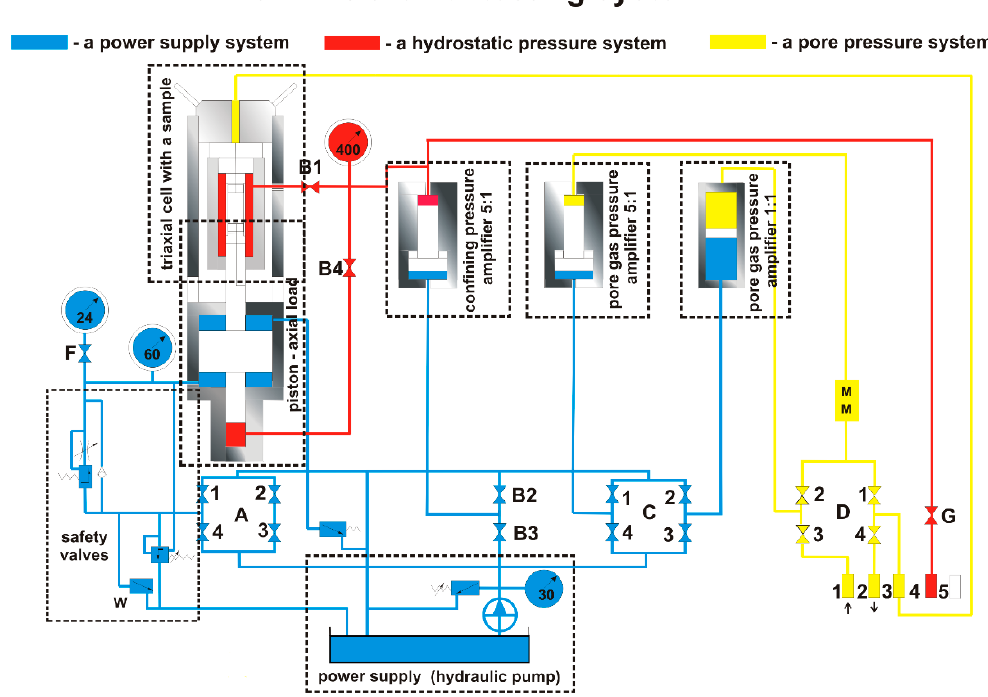
Figure 4. Diagram of the GTA-10 device: A1, A2, A3, A4—valves controlling the movement of the press piston, B1, B4—valves that control the flow of liquid in the high pressure cell, B2, B3—valves controlling liquid pressure in a triaxial cell through a pressure amplifier with a ratio of 5:1, C1, C2, C3, C4—valves controlling pore pressure in a sample through a low pressure amplifier with a ratio of 1:1 (on the right) and high pressure amplifier with a ratio 5:1 (on the left), D1, D2, D3, D4—valves controlling the flow of pore gas to and from inside the tested sample; reproduced from [31], Arch. Min. Sci.: 2021. Reproduced from [31], Polish Academy of Sciences, Committee of Mining: 2021.